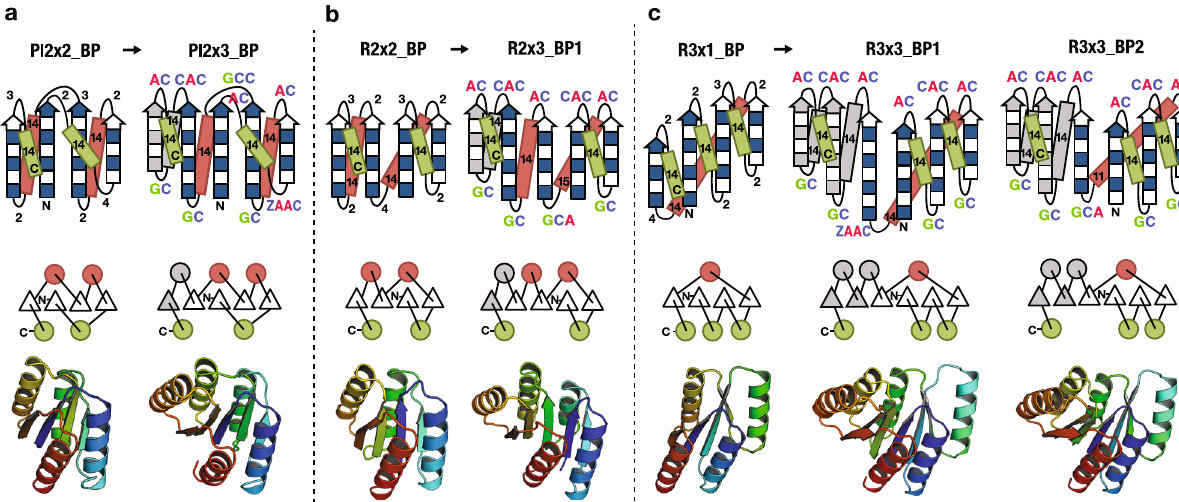
Fig. 1 Backbone blueprints and design models for target folds. (top) Backbone blueprints for a P-loop2×3-fold: Pl2×3_BP, b Rossmann2×3-fold: R2x3_BP1, c Rossmann3×3-fold: R3×3_BP1 and R3x3_BP2. Helix lengths are represented by numbers within green and red rectangles, strand residues indicated by fi lled and open boxes: fi lled boxes represent pleats (the vectors from C α atom to C β atom) coming out of the page and the open boxes represent pleats going into the page. Loops are labeled by the extended ABEGO torsion patterns (see Methods and Supplementary Fig. 1). (middle) Design topologies are illustrated with circles (helices) and triangles (strands) connected by solid lines (loops). (bottom) Design models created from the blueprints (top). The blueprints were created by inserting an αβ or αβ - αβ motif (gray color) into the position immediately before the C-terminal helix in the blueprints we used previously to design four-stranded β -sheet proteins 6 . The secondary structure lengths and the loop ABEGO patterns are based on the design rules for βαβ - motif described in Fig. S5 and S6 of ref. 9 , with the extension of the ABEGO bins. For Rossmann3×3-fold, we experimented with two blueprints, changing the register shift and the length of the fourth